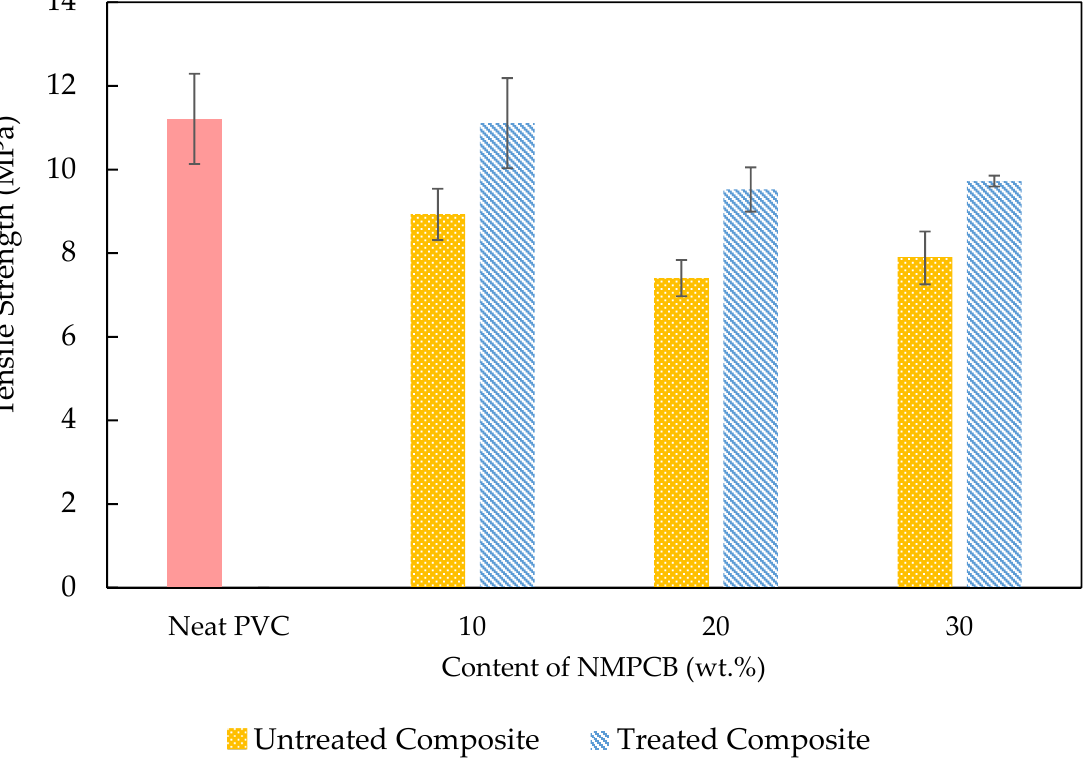
Figure 6. Tensile strength of untreated and treated NMPCB/PVC composites.